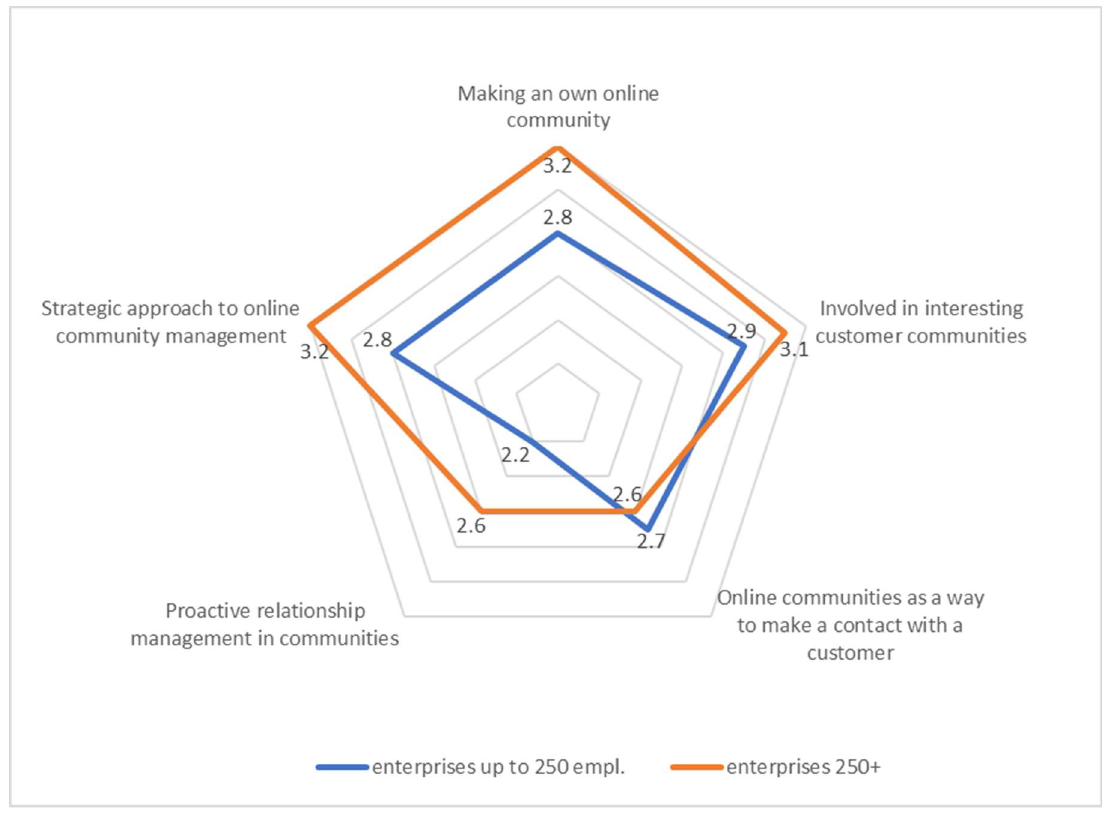
Figure 1. Differences in online community management according to organization size.